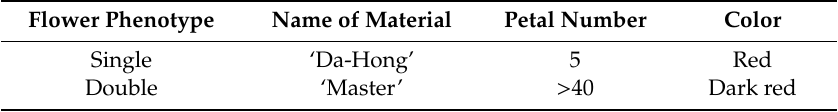
Figure 1. Characteristics of single (‘Da hong’) and double (‘Master’) flower phenotype carnations. ( A – D ) represent flower, sepals, petals, and carpel of ‘Da hong’, respectively. ( E – H ) represent flower, sepals, petals, and carpel of ‘Master’, respectively. ‘Da hong’ and ‘Master’ with petals of 5 and more than 40, respectively. Bar = 1 cm. Table 1. Information of the experimental